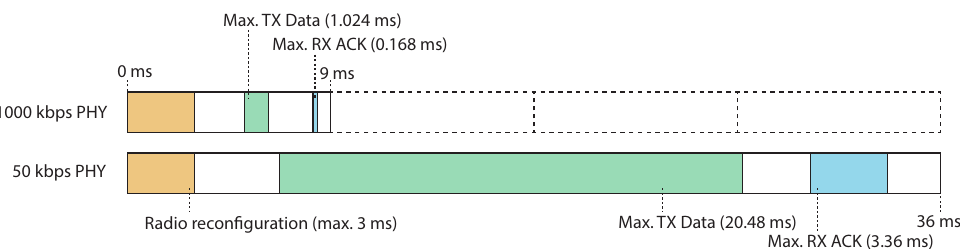
Figure 4. Illustration of the slot timings for the 1000kbps and 50kbps (bonded)